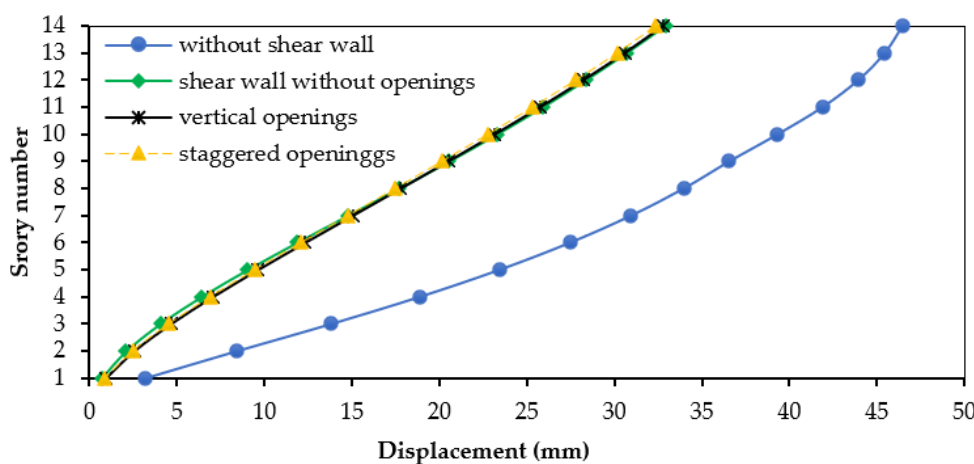
Figure 11. Story displacement of the models, time history analysis, X-direction.